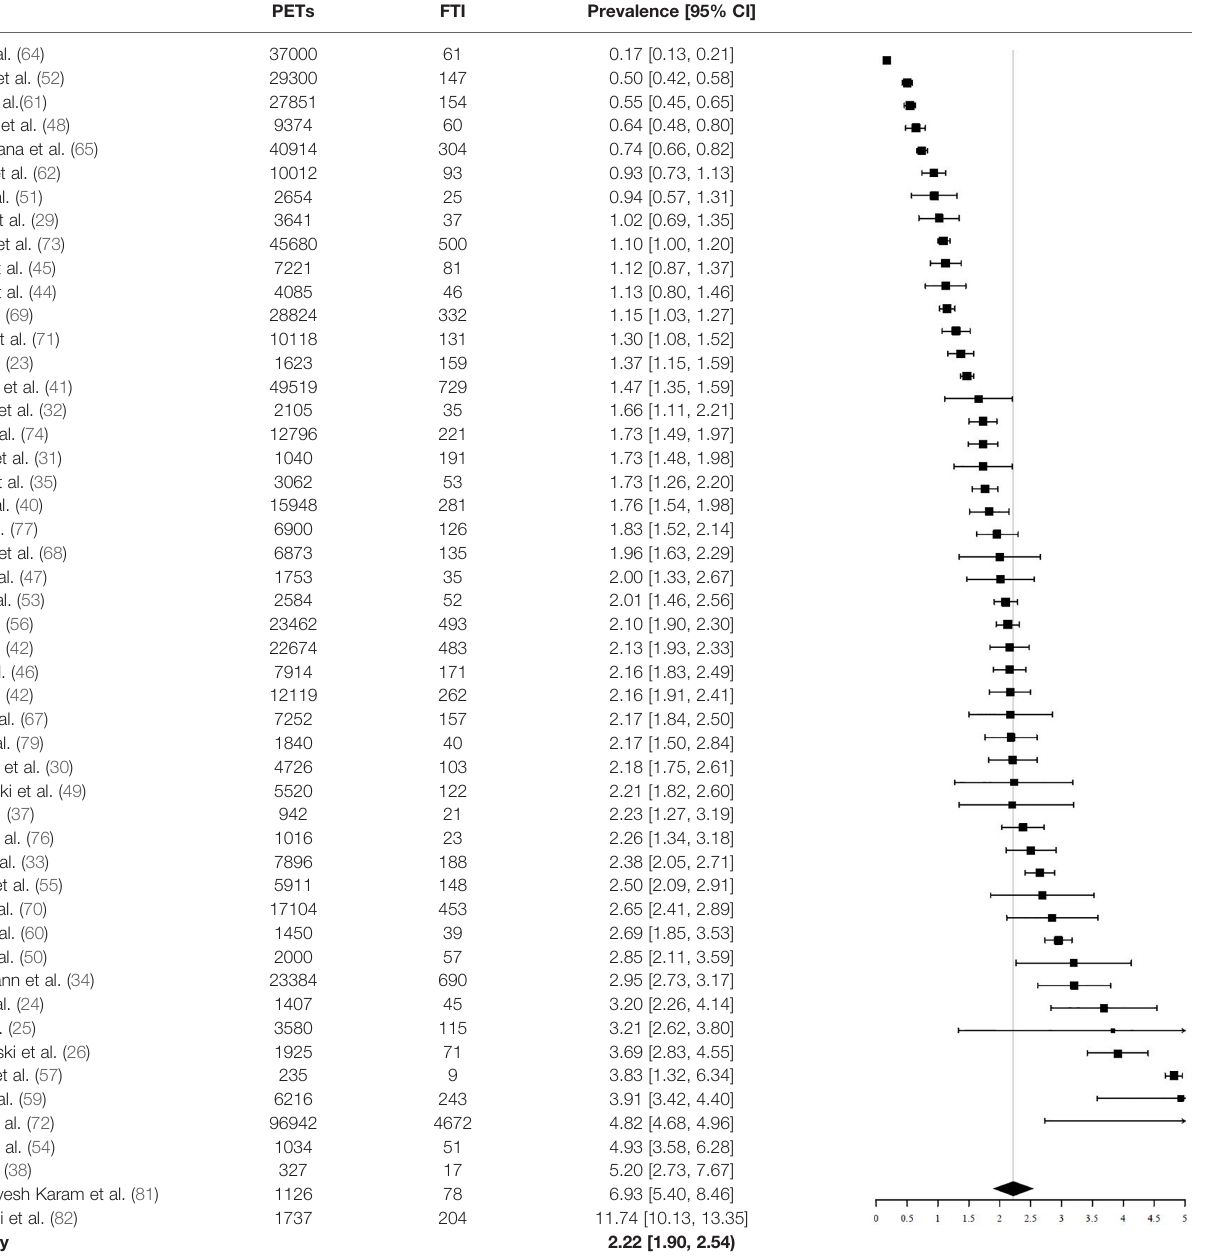
TABLE 3 | Prevalence of FTI (random effects, I 2 = 99%, symbol size re fl ects weight). Study PETs FTI Prevalence [95% CI] Vaish et al.